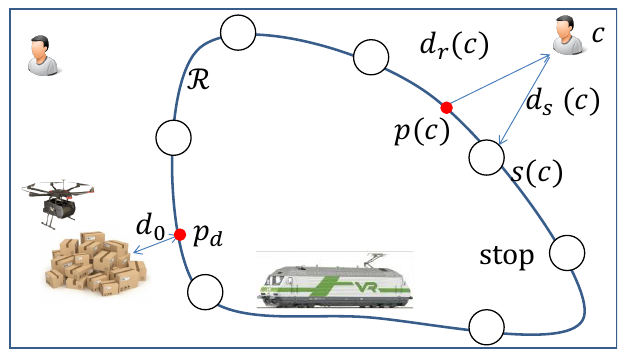
Figure 1. The considered parcel delivery system. Table 1. Notations and